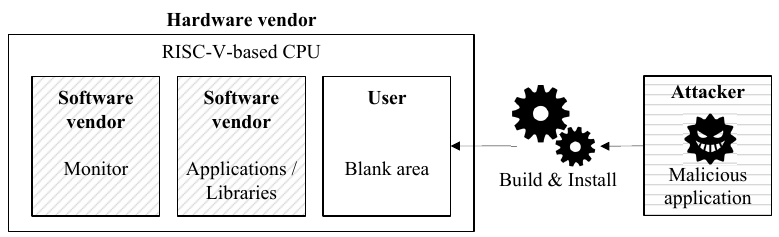
Figure 3: Attack scenario based on a use case for ARM TrustZone